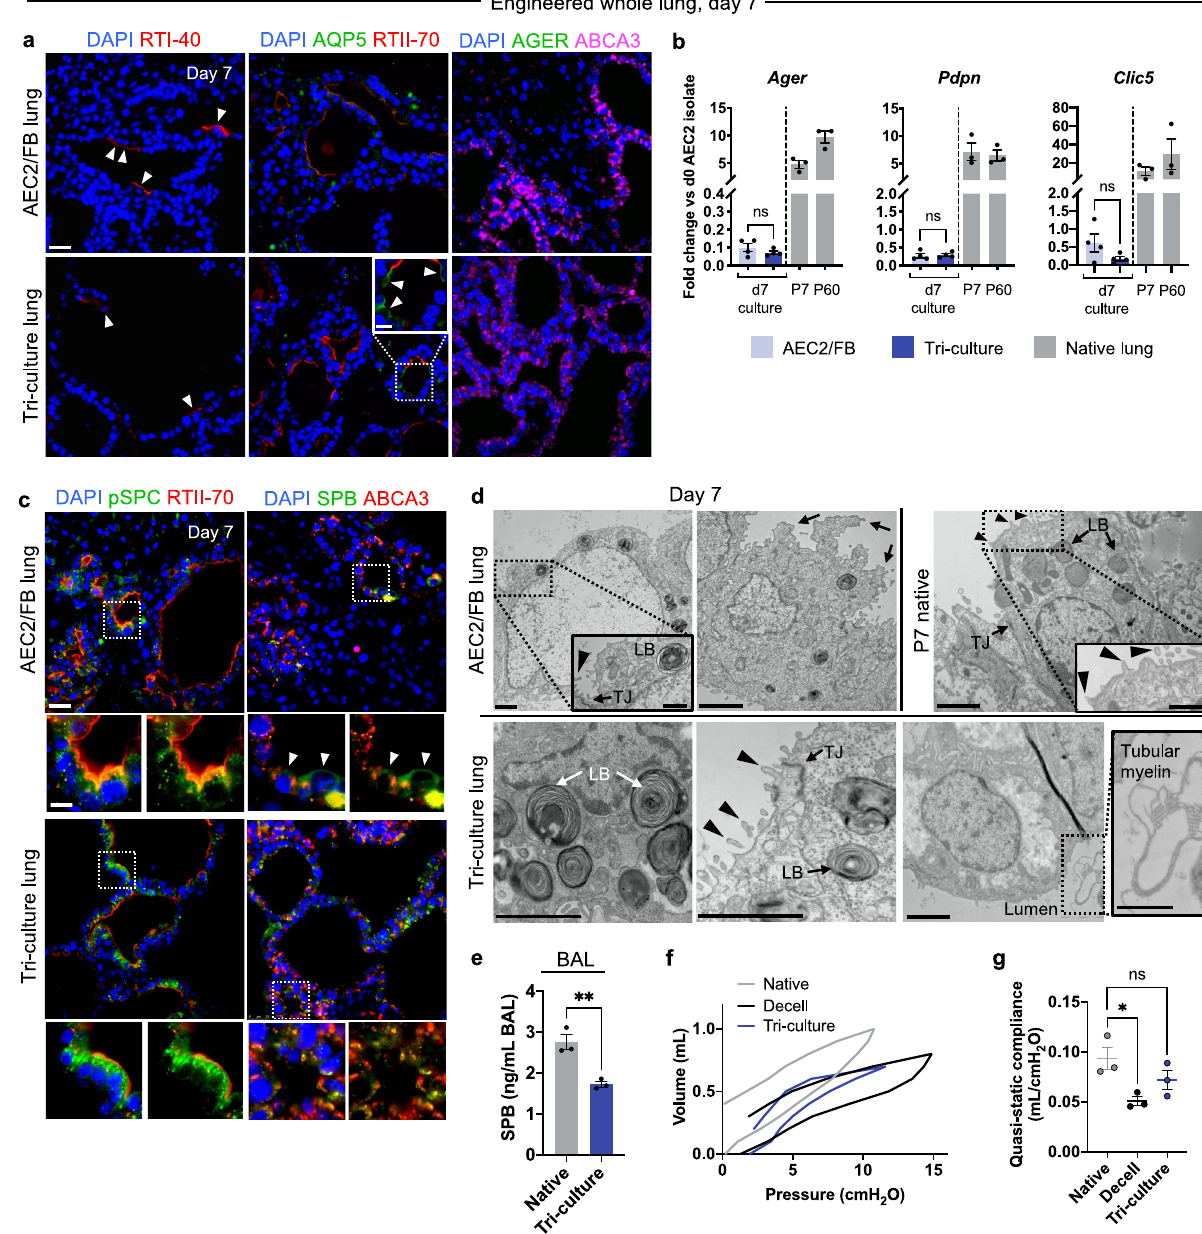
Fig. 2 Endothelial co-culture enhances AEC2 phenotype in the setting of fi broblasts. a Immunostaining for AEC1 markers RTI-40, AQP5, and AGER in d7 engineered lungs. Arrowheads, cells staining positive for AEC1 markers. b qRT-PCR of AEC1 gene expression in d7 engineered lungs; n = 4 lungs. Gene expression in native P7 and P60 rat lungs is normalized to the average expression in day 0 AEC2 isolates and shown for approximate comparison only; n = 3 lungs. c Immunostaining of AEC2 proteins in AEC2/FB and tri-culture lungs. Arrowheads indicate diffuse cytoplasmic SPB labeling in AEC2/FB co-cultured epithelium. d TEM examining epithelial ultrastructural features in engineered lungs, with a P7 native AEC2 shown for comparison. LB lamellar body, TJ tight junction. Arrowheads, apical microvilli. Arrows, irregular apical projections. Scale bars, 2 μ m. Magni fi ed regions, 1 μ m. e Quanti fi cation of secreted SPB protein in bronchoalveolar lavage (BAL) of adult rat ( “ Native ” ) and tri-culture engineered lungs; n = 3 lungs. Representative quasi-static pressure-volume (PV) curves ( f ) with calculation of compliance ( g ) for native, decellularized, and tri-culture lungs; n = 3 biological replicates. Scale bars in immuno fl uorescence images, 25 μ m. Magni fi ed regions, 10 μ m. Error bars indicate the mean ± SEM. b , e Unpaired two-tailed t -test. g One-way ANOVA with Holm – Sidak ’ s multiple comparisons tests. ns not signi fi cant, * P < 0.05, ** P < consistent punctate localization by immunostaining (Fig. 2c). By electron microscopy (TEM) con fi rmed the presence of well-formed TEM, co-culture AEC2s exhibited aberrant epithelial cell ultra- lamellar bodies in tri-culture AEC2s, as well as characteristic apical structure, including enlarged nuclei and irregular apical projec- microvilli and tight junctions (Fig. 2d). Tri-culture AEC2s were also tions (Fig. 2d). These features suggest a loss of the appropriate associated with luminal tubular myelin, a structure characteristic AEC2 cellular program in the setting of FB-only co-culture in lung of secreted surfactant (Fig. 2d) 46 . In contrast, AEC2/FB lung AEC2s demonstrated only weak surfactant protein expression, without scaffolds.